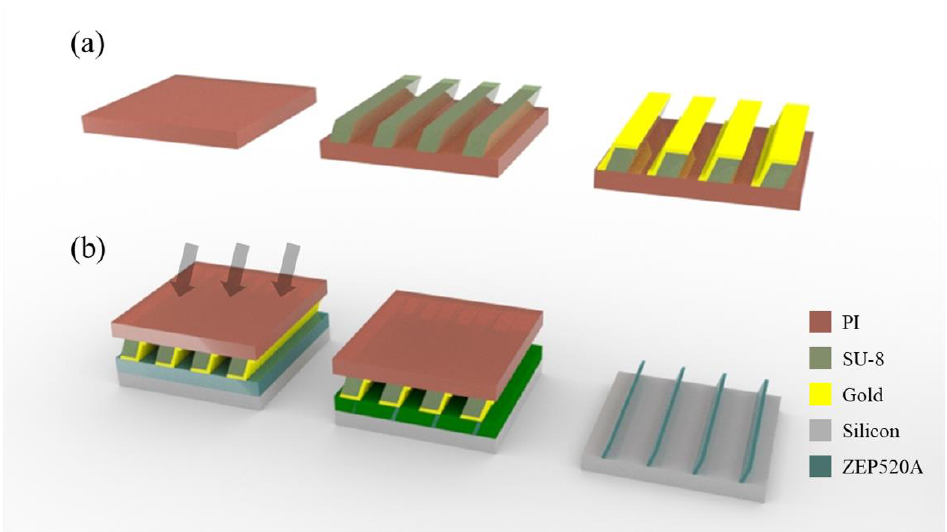
Figure 3. Fabrication process of the oblique sub-micron ( a ) X-ray mask and ( b ) line structure using X-ray lithography.